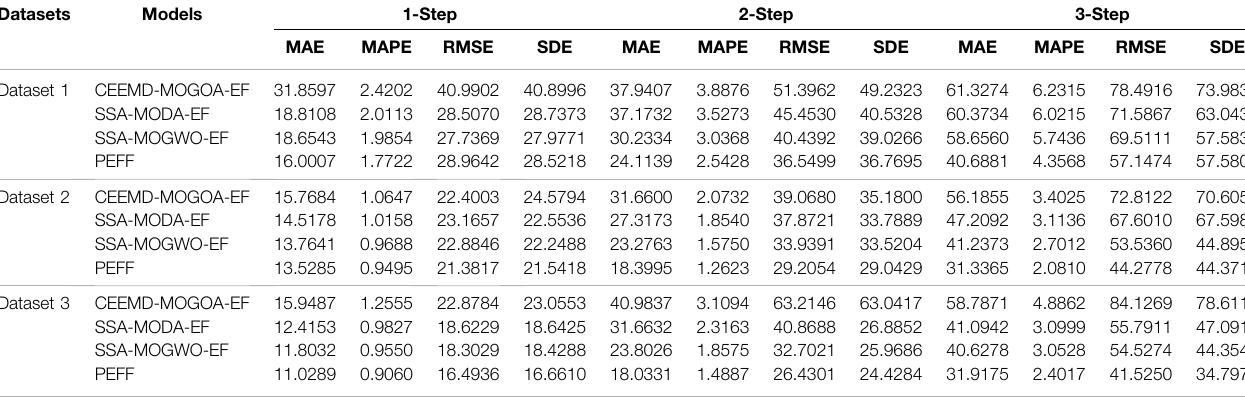
TABLE 5 | Comparison of the forecasting performance of the PEFF and EFs employing other ensemble strategies. Datasets